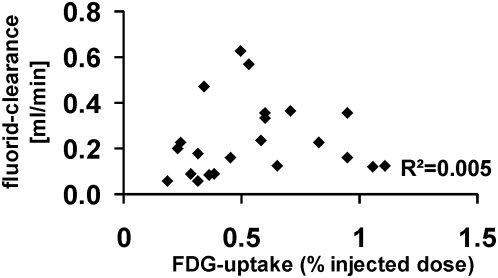
Relation of the 18F-fluoride clearance (ml/min) to the FDG uptake (%ID).No correlation of these two parameters was found (R2 = 0.005, n = 22).